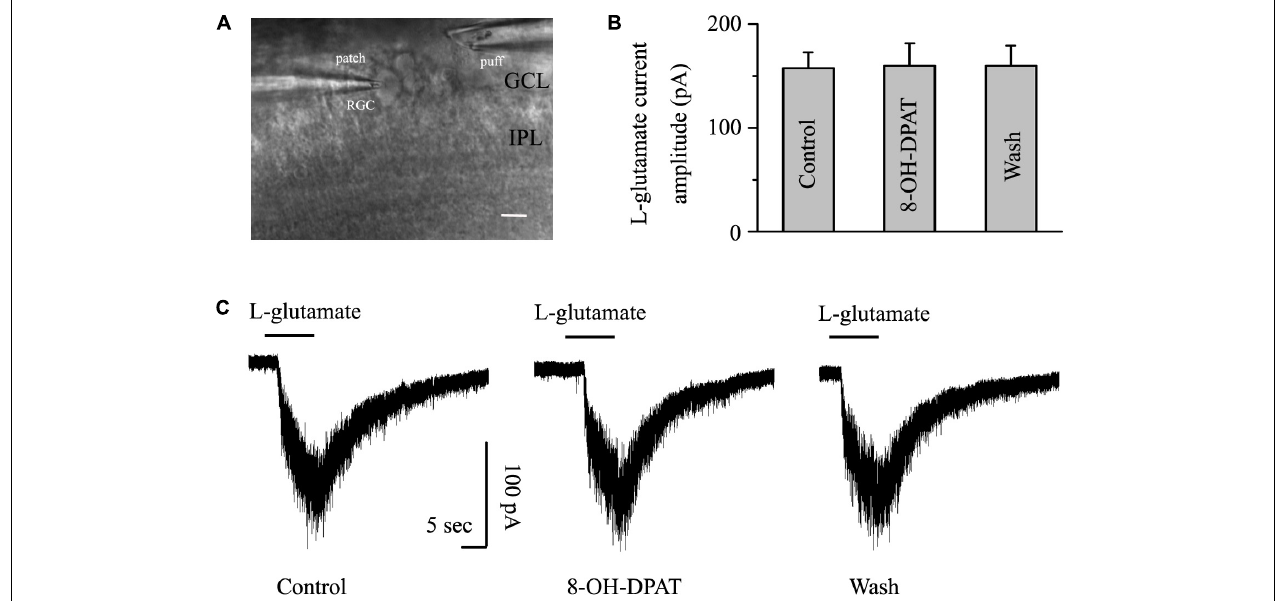
FIGURE 8 | 8-OH-DPAT did not change the amplitude of L -glutamate-induced current in OFF- and ON-type RGCs. The micrograph in (A) was taken with an infrared interferometric phase microscope, and the retinal layers can be seen. The microelectrode on the left was used for sealing the RGC, and the microelectrode on the right was used for pressure injection. (B) Bar graph illustrating no differences in the peak amplitudes of the responses recorded from control, 8-OH-DPAT and recovery conditions ( n = 7). (C) Representative traces of L -glutamate-induced current during control (left), 8-OH-DPAT (middle), and wash (right) conditions. Vertical scale bar: 100 pA; horizontal scale bar: 5 s. GCL, ganglion cell layer; IPL, inner plexiform layer. Scale bar: 10 µ m.